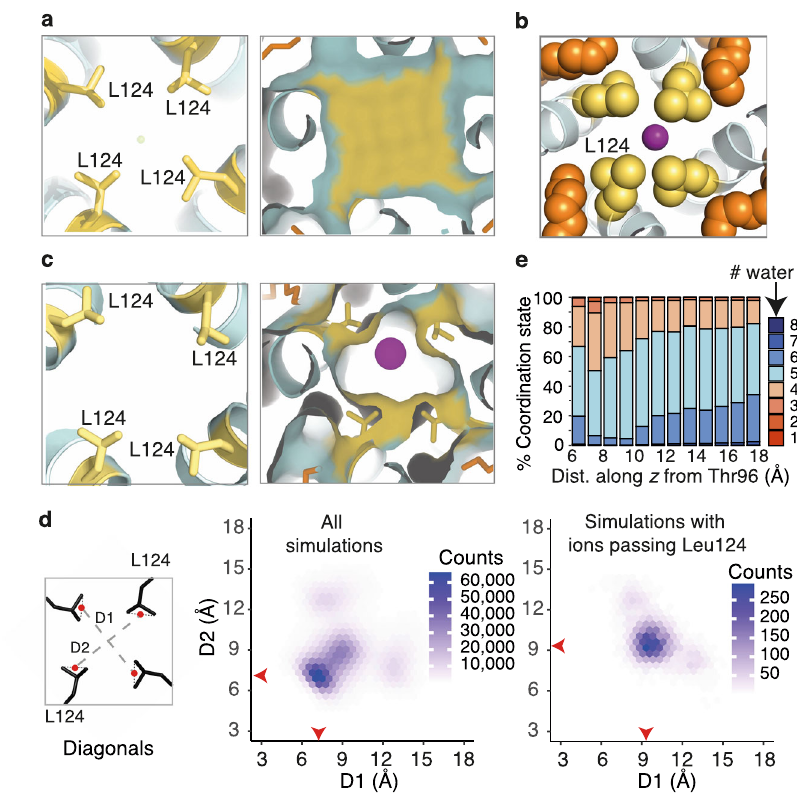
Fig. 2 Competition for the aliphatic side chains of Leu124 by extended alkyl chains in the fenestrations is suf fi cient to disrupt the leucine collar and allow K + to pass. a (Left) Cross-sectional slice through the KirBac3.1 pore (cyan) showing the central Leu124 side chains. (Right) Accessible molecular surface demonstrating occlusion of the conduction pathway at the Leu124 collar. Side chains and surface of Leu124 are coloured yellow, lipidic alkyl chains orange, and potassium depicted as purple spheres. b Close-up representation showing the interaction of Leu124 (yellow spheres) and fenestration lipid (orange spheres). c Comparable region of a representative simulation structure extracted as a K + ion passes the leucine collar. d Hexagonal bin plots of D1 against D2 (aperture diagonals) for structures extracted from unbiased non-equilibrium MD simulations. Distances are between points (red dots in the schematic) midway between C δ 1 and C δ 2. Red arrows on the plots indicate the population of highest density. (Left) Analysis of all structures. (Right) Analysis of those structures in which a K + is passing the collar. e Normalized histograms of data extracted from umbrella sampling simulations enumerate the number of (water) oxygen atoms coordinating each conducted K + ion as a function of linear distance from Thr96. Each column represents the number of oxygen atoms within 3.0 Å of K + , expressed as a percentage. Source data are provided as a Source data fi